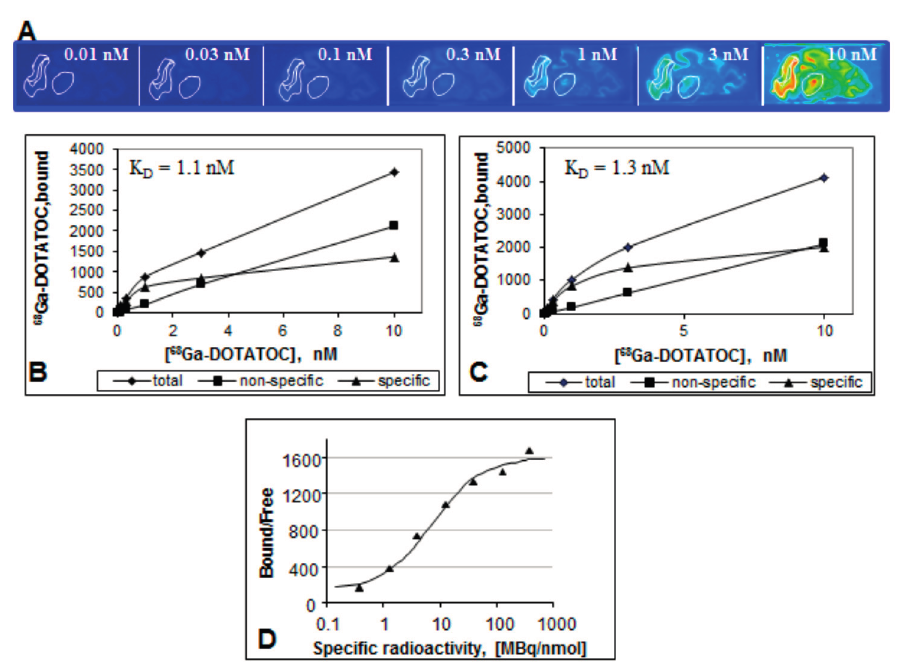
Figure 15. ( A ) Frozen section autoradiography showing [ 68 Ga]Ga-DOTA-TOC binding to SSTR of rhesus monkey thalamus and cortex. The brain sections were incubated with different concentrations of [ 68 Ga]Ga-DOTA-TOC (0.01–10 nM) for 30 min at room temperature; ( B , C ) Saturation of [ 68 Ga]Ga-DOTA-TOC binding to SSTR of Rhesus monkey thalamus ( B ) and cortex ( C ); ( D ) The ratio of the ligand bound to the receptor and the